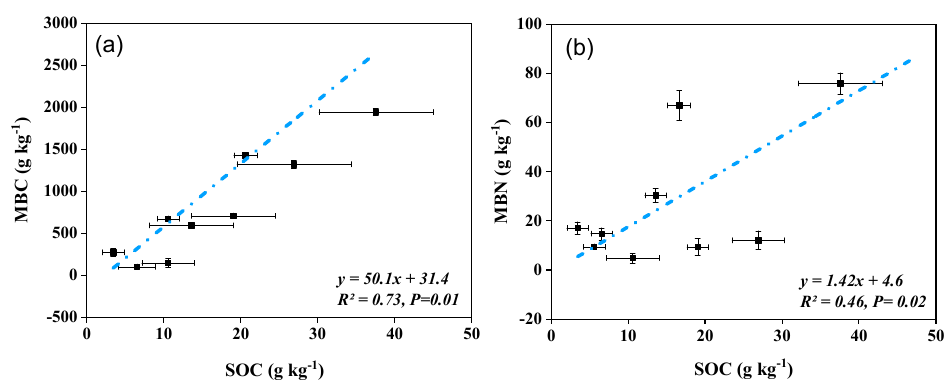
Figure 3. A linear relationship between soil organic carbon (SOC) and ( a ) soil microbial biomass carbon (MBC), and ( b ) soil microbial biomass nitrogen (MBN) across the soil depths and sub-tropical forest types in northeastern Hunan province, south central China.